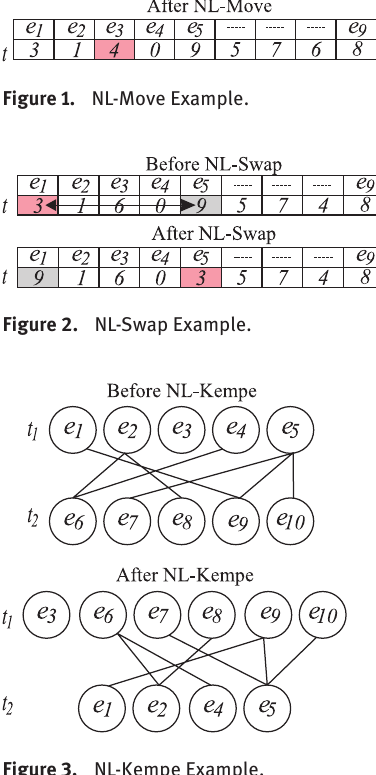
Figure 3. NL-Kempe